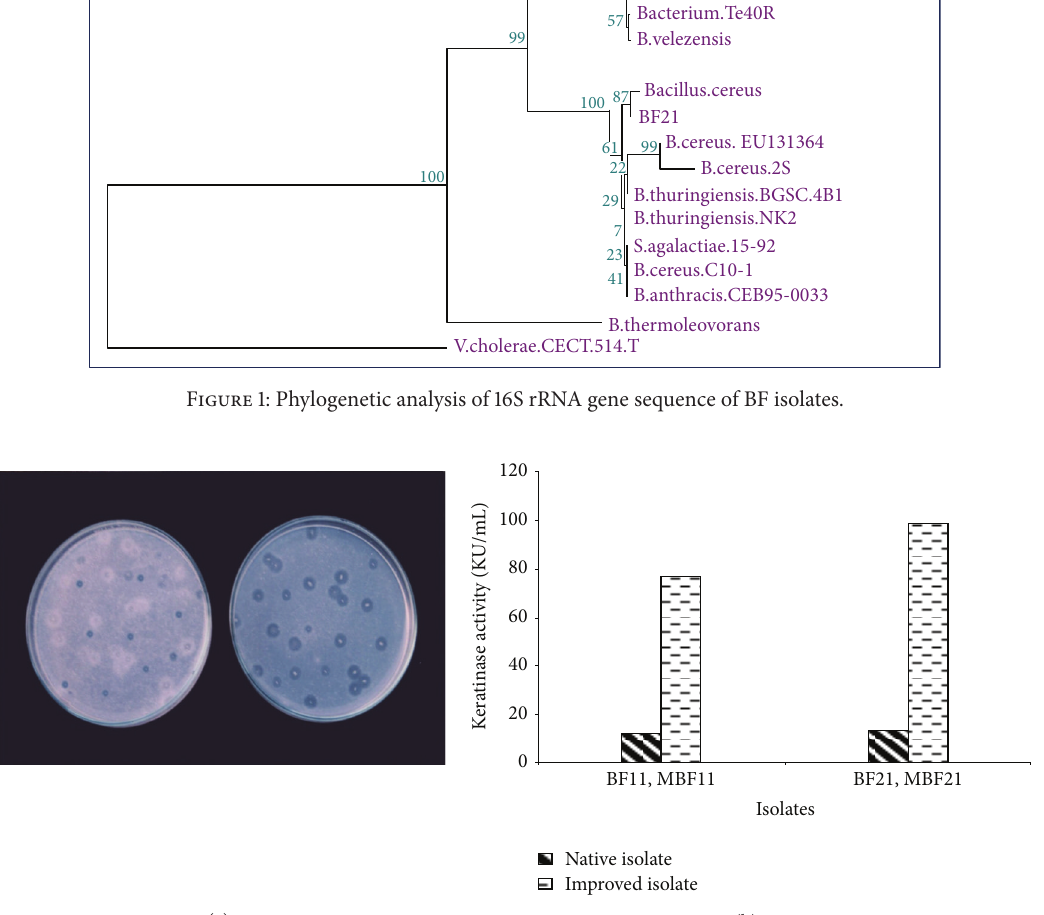
observed for both the isolates. Yeast extracts were the other nitrogen sources supporting enzyme production.